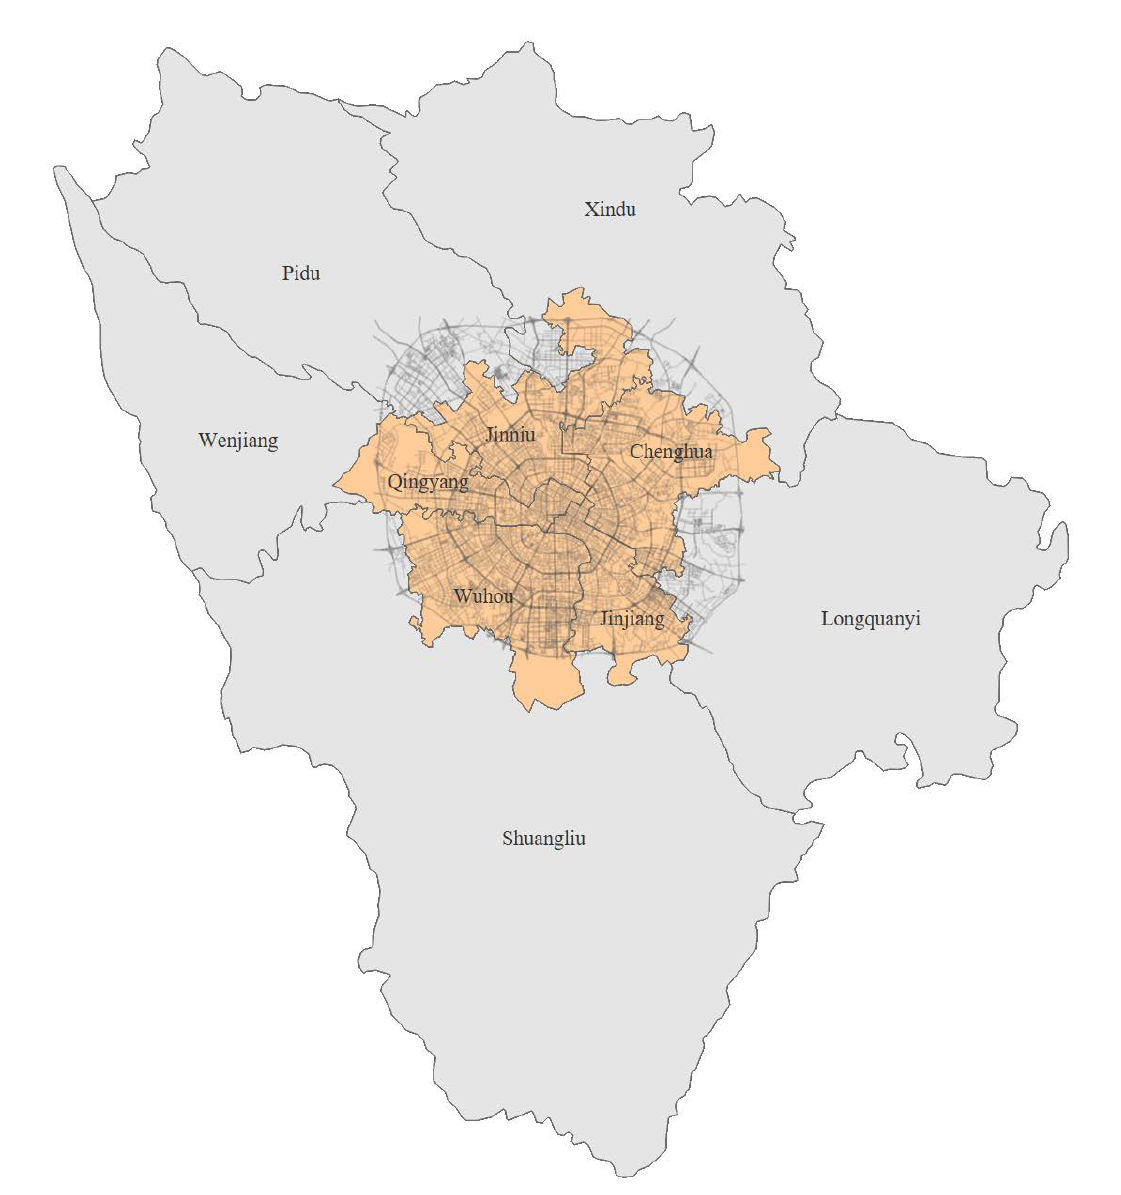
Figure 14. Case study area: Administrative districts of Chengdu in this study